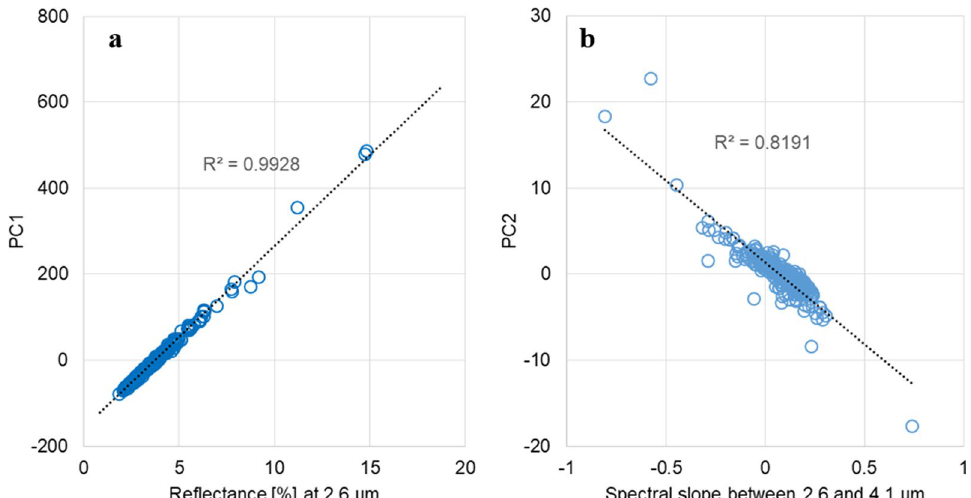
Fig. 6 Parameters related to PC1 and PC2. a PC1 is highly correlative with the reflectance of samples represented at 2.6 μm. b PC2 seems to correlate with the spectral slope in the analyzed wavelength range (2.6–4.1 μm)